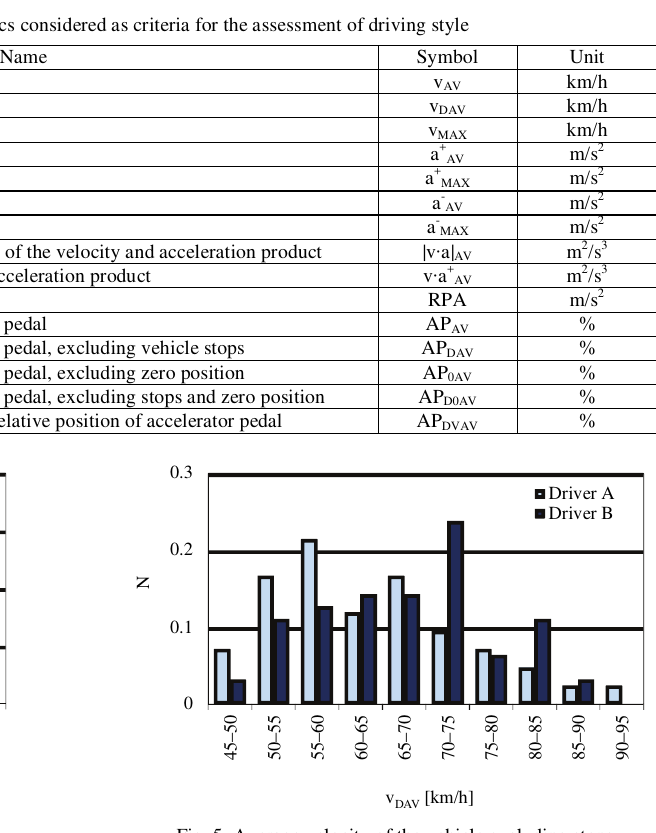
Fig. 2. Average velocity of the vehicle in urban driving conditions